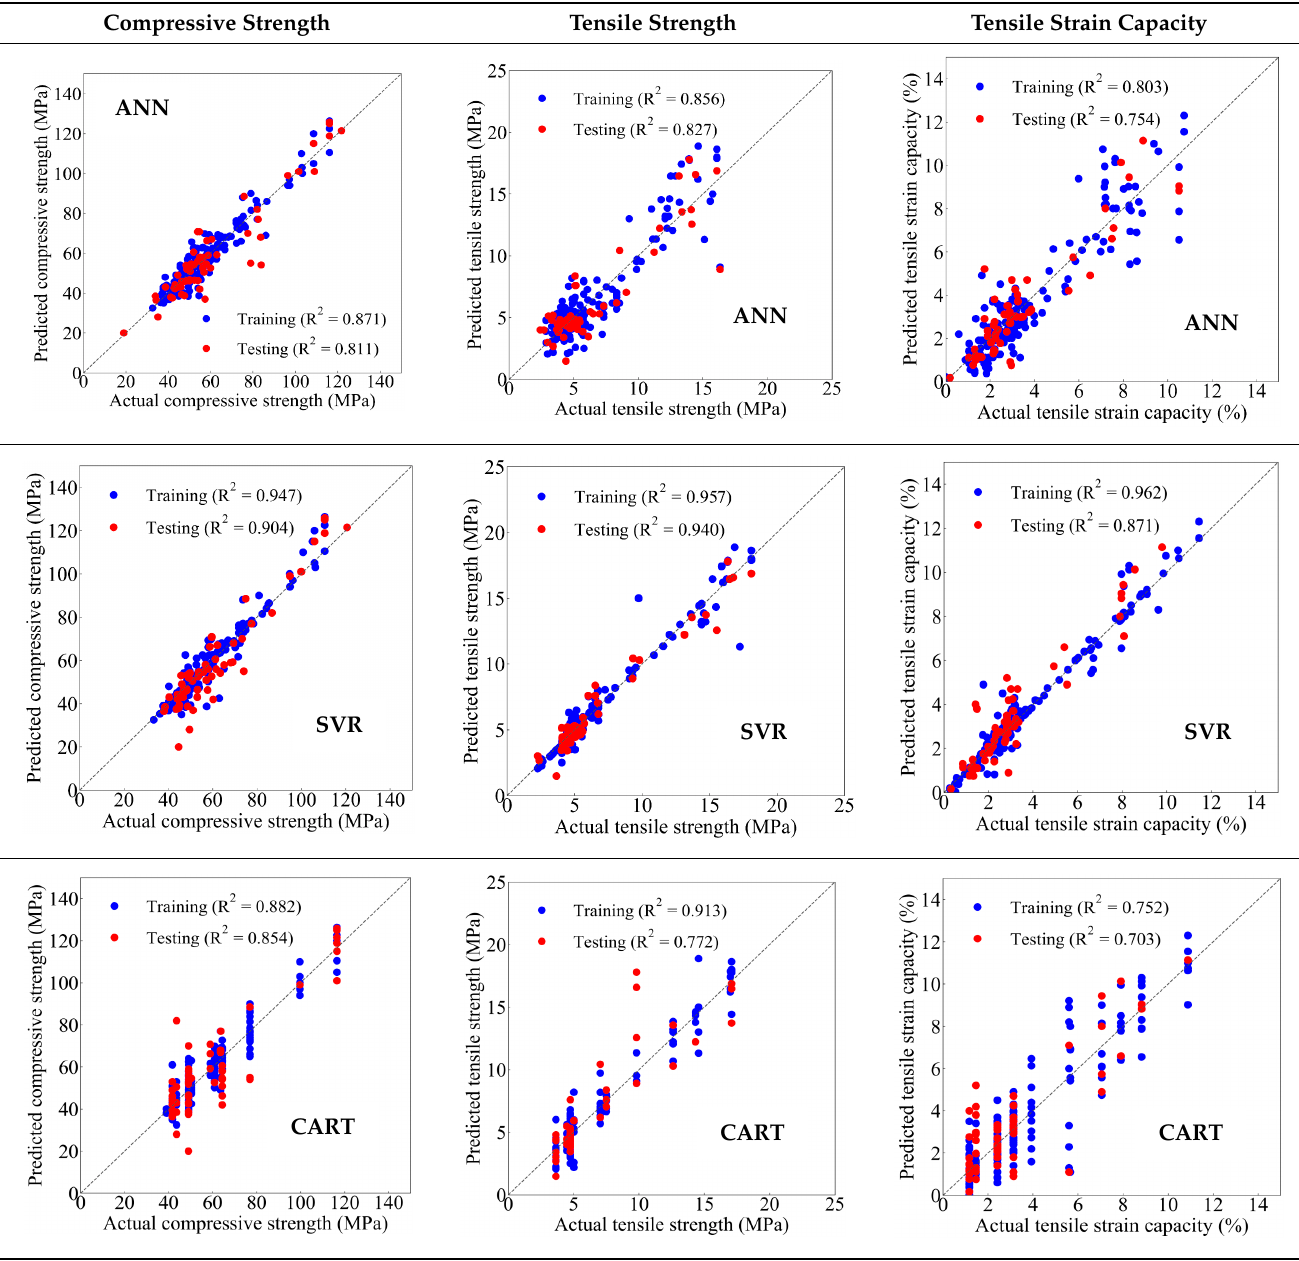
Figure 7. Learning curve for the training process (tensile strength) using: ( a ) ANN, ( b ) SVR, ( c ) CART, and ( d ) XGBoost. Table 4. Comparison of the predicted and the actual values of the mechanical properties. Table 4. Comparison of the predicted and the actual values of the mechanical Table 4. Comparison of the predicted and the actual values of the mechanical properties. Table 4. Comparison of the predicted and the actual values of the mechanical properties. Table 4. Comparison of the predicted and the actual values of the mechanical properties. Table 4. Comparison of the predicted and the actual values of the mechanical properties. Table 4. Comparison of the predicted and the actual values of the mechanical properties. Table 4. Comparison of the predicted and the actual values of the mechanical properties. Table 4. Comparison of the predicted and the actual values of the mechanical properties. Table 4. Comparison of the predicted and the actual values of the mechanical properties.